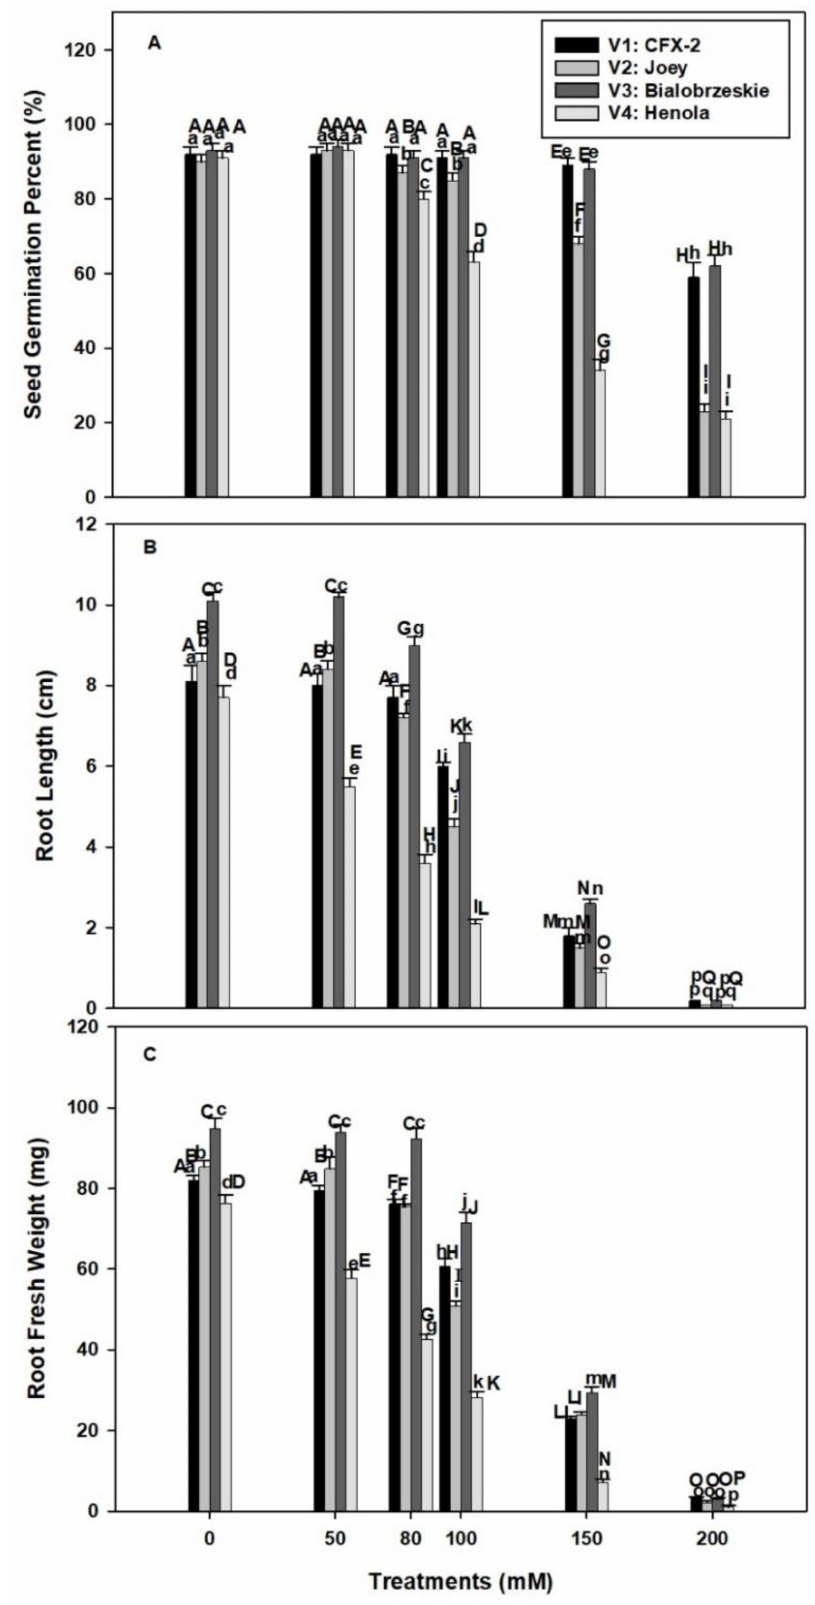
Figure 1. Effects of NaCl on IH SGP ( A ), RL ( B ), and RFW ( C ). Vertical bars represent SE. Different capital letters indicate significant differences among the varieties and lower case letters represent significant treatment differences. These mean values ( n = 45) are separated using LSD at p <